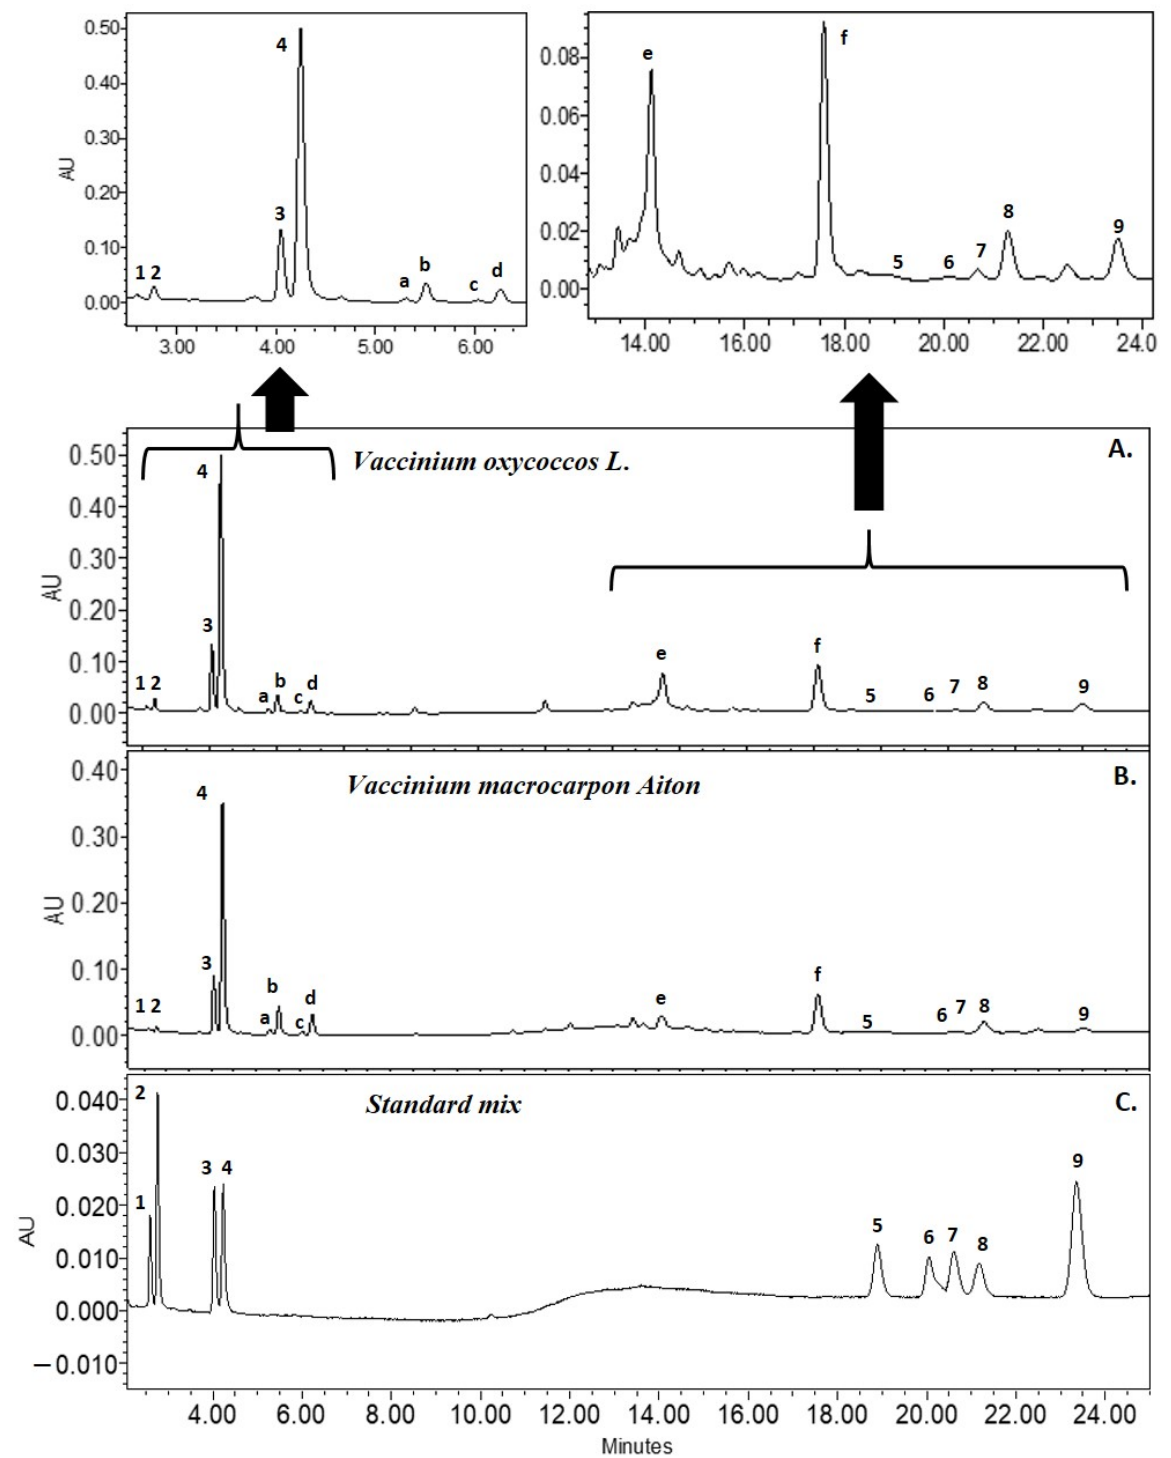
Figure 2. UPLC-DAD profile of cranberry fruit samples ( A ) and ( B ) and the mix of standards ( C ) at 205.5 nm. Chromatogram of the mix of standards ( C ): (1) maslinic acid 21 µg/mL, (2) corosolic acid 46 µg/mL, (3) oleanolic acid 27 µg/mL, (4) ursolic acid 25 µg/mL, (5) β -Amyrin 42 µg/mL, (6) campesterol 42 µg/mL, (7) α -Amyrin 42 µg/mL, (8) β -Sitosterol 42 µg/mL, and (9) squalene 21 µg/mL. Chromatogram of cranberry samples ( A ), ( B ): unidentified analytes a, b, c, d, e, f with λ max.